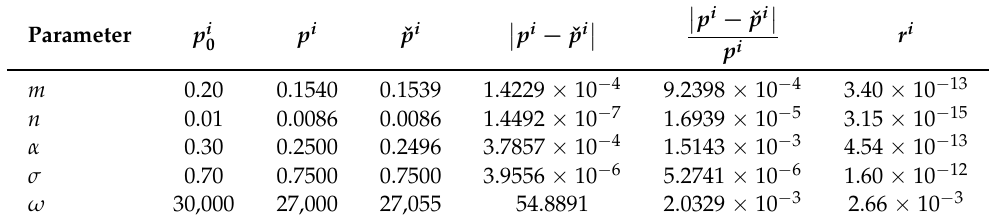
Table 5. Test with the integer-order derivative model ( r = q = 1).